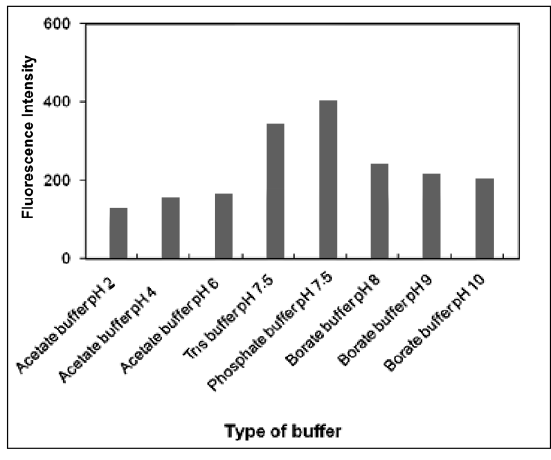
Fig.4. Effect of different buffer types on fluorescence intensity of